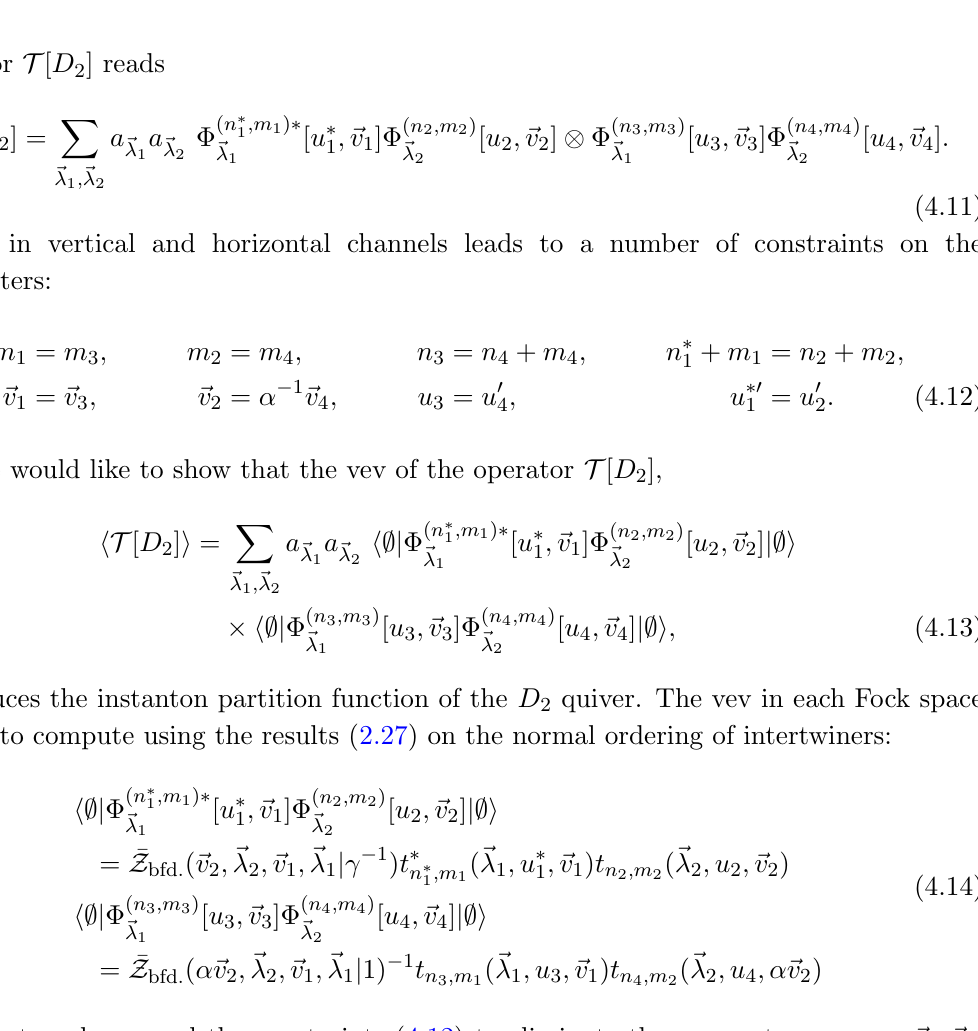
Figure 8 . DIM representation web for a D 2 quiver (left) and the corresponding ( p; q )-brane web diagram for gauge groups of rank m s = 2